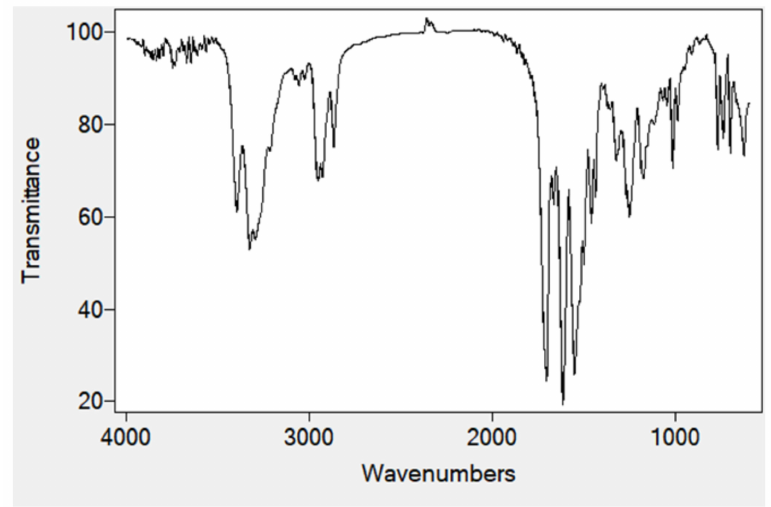
Figure 4. FTIR spectrum of compound 1 .